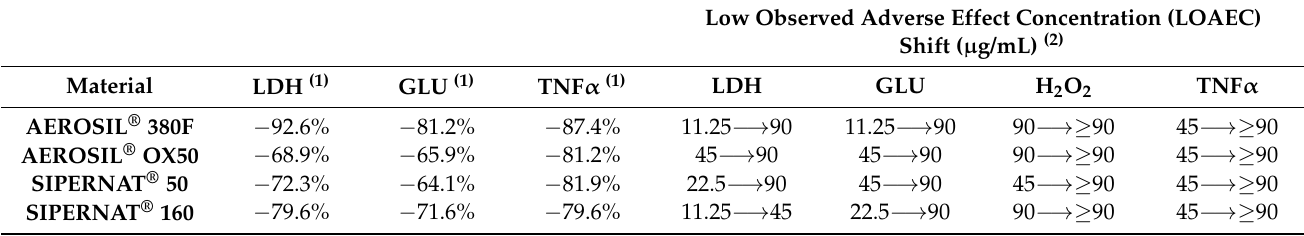
Table 3. Apparent reduction of the bioactivity of SAS nanoparticles upon addition of FCS. Low Observed Adverse Effect Concentration